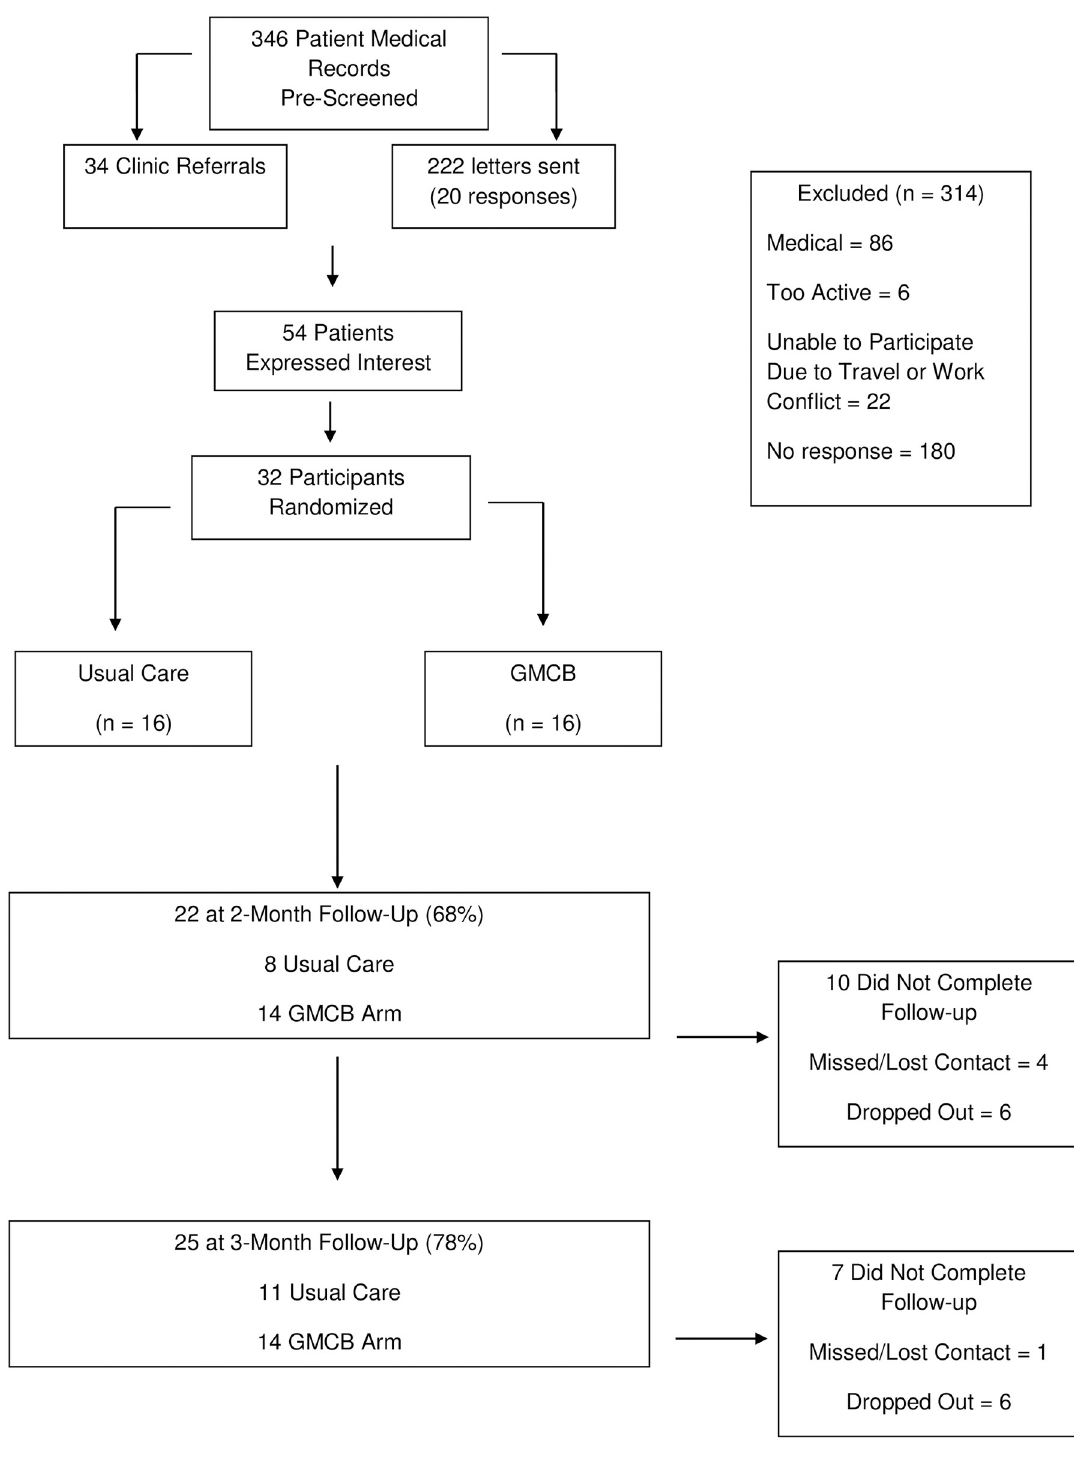
Fig 1. CONSORT diagram of participant flow through the IDEA-P trial.